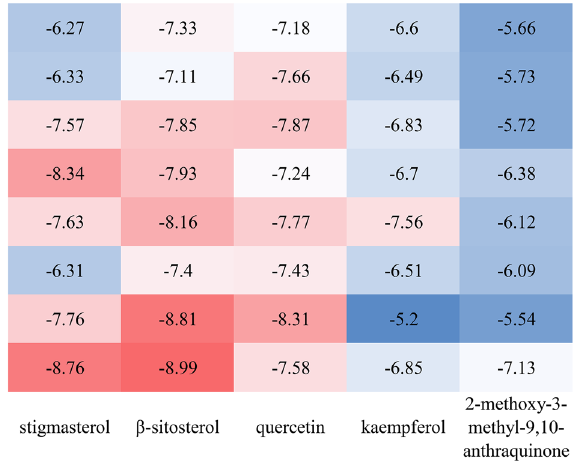
Figure 5. Molecular docking heatmap of the main compounds and key targets (kcal/mol). The figure shows the size of the binding energy. The larger the absolute value, the redder the color, indicating increasing stability of the combination of the component and the target